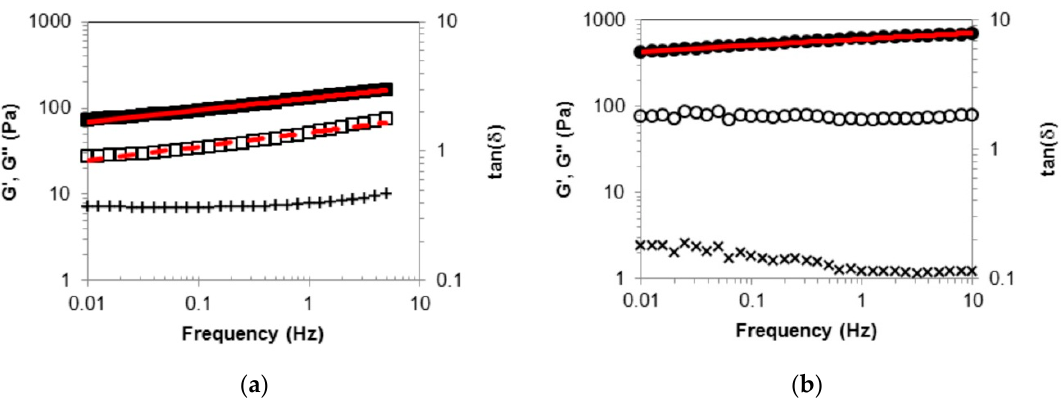
Figure 5. Dynamic moduli, G ′ (filled symbols) and G ″ (empty symbols), and loss tangent (crosses) versus the frequency of the oscillatory stress for the freshly prepared 1% w / w gels in paraffin oil: ( a ) (R) -9-HSA; ( b ) (R) -12-HSA. The red solid lines are the power fits for G’ data and the red dashed line for G’’ data.